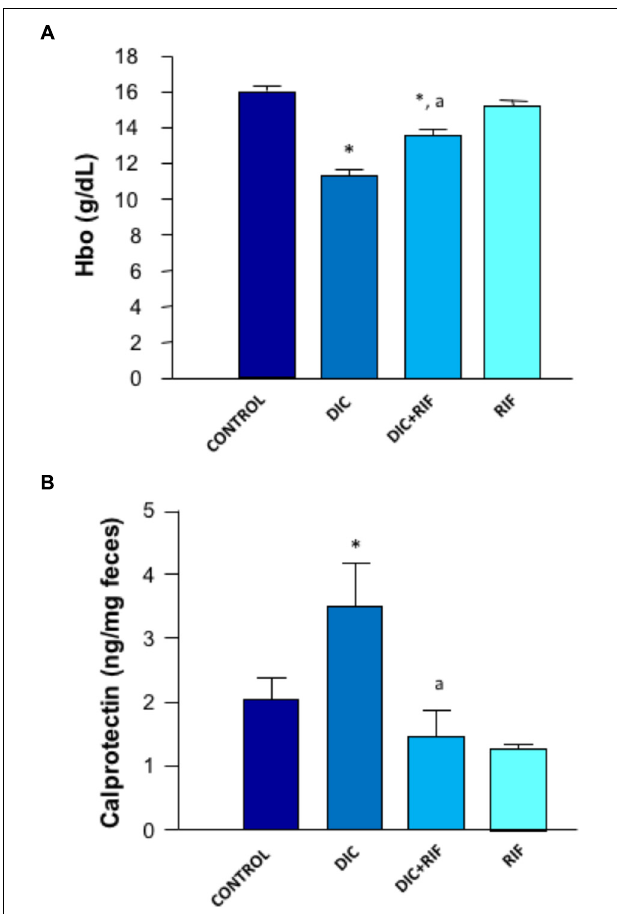
FIGURE 2 | Effects of vehicle (Control), diclofenac (DIC, 4 mg/kg BID), diclofenac plus rifaximin (DIC+RIF, 50 mg/kg BID), or rifaximin (RIF) for 14 days on blood hemoglobin (A) or fecal calprotectin levels (B) . Each column represents the mean ± SEM obtained from 10 animals. ∗ p < 0.05, significant difference versus Control; a p < 0.05, significant difference versus diclofenac